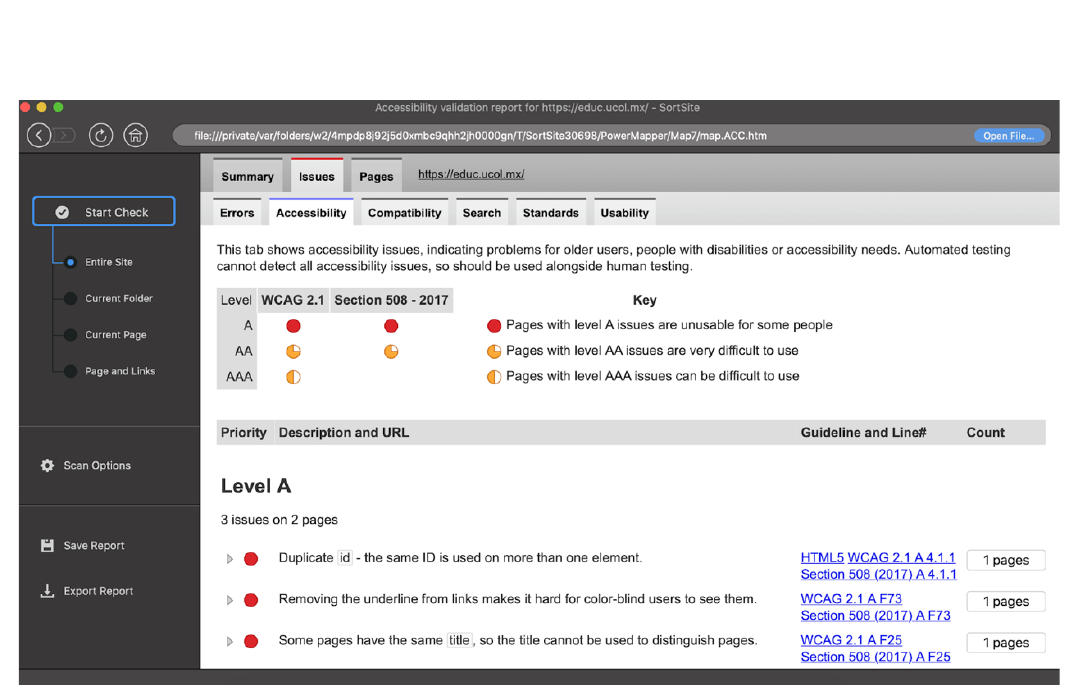
Figure 9 . Results of the Accessibility validation report for EDUC (landing page).